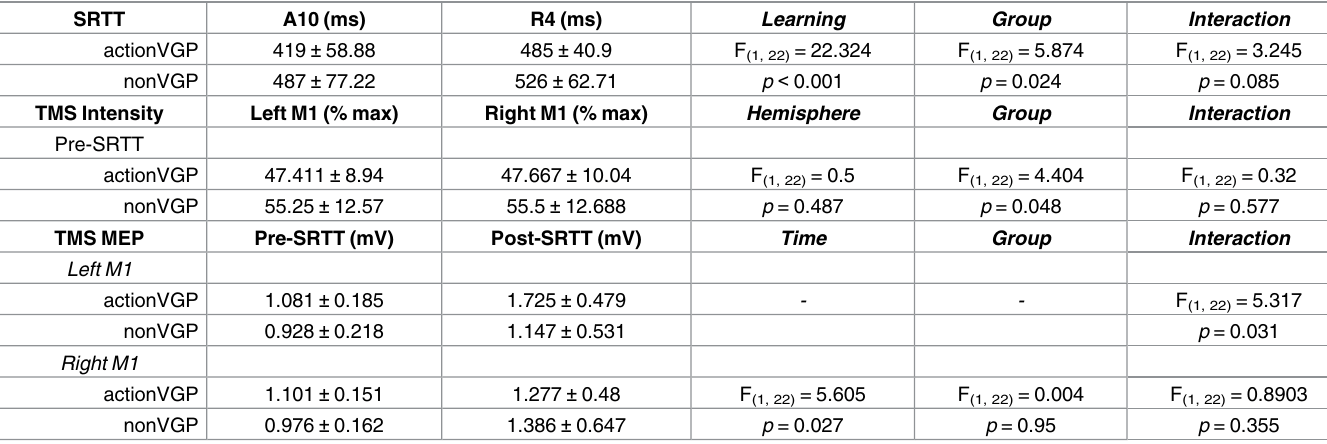
Results of the mixed ANOVAs conducted for the SRTT and the TMS are displayed. For the SRTT, the means and standard deviations of the participants RTs on blocks A10 and R4 are expressed in milliseconds(ms). For the TMS intensity measures, the means and standard deviations represent the percentage of the stimulation device’s maximum output. For the TMS MEP, the means and standard deviations of the participants’ MEP amplitudes are expressed in millivolts